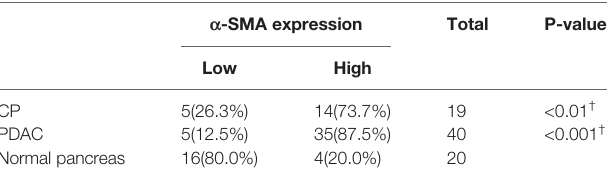
Differential expression of a -SMA in CP/PDAC tissues and normal Pancreatic tissues was compared using the c 2 test. † : Compared with normal Pancreatic